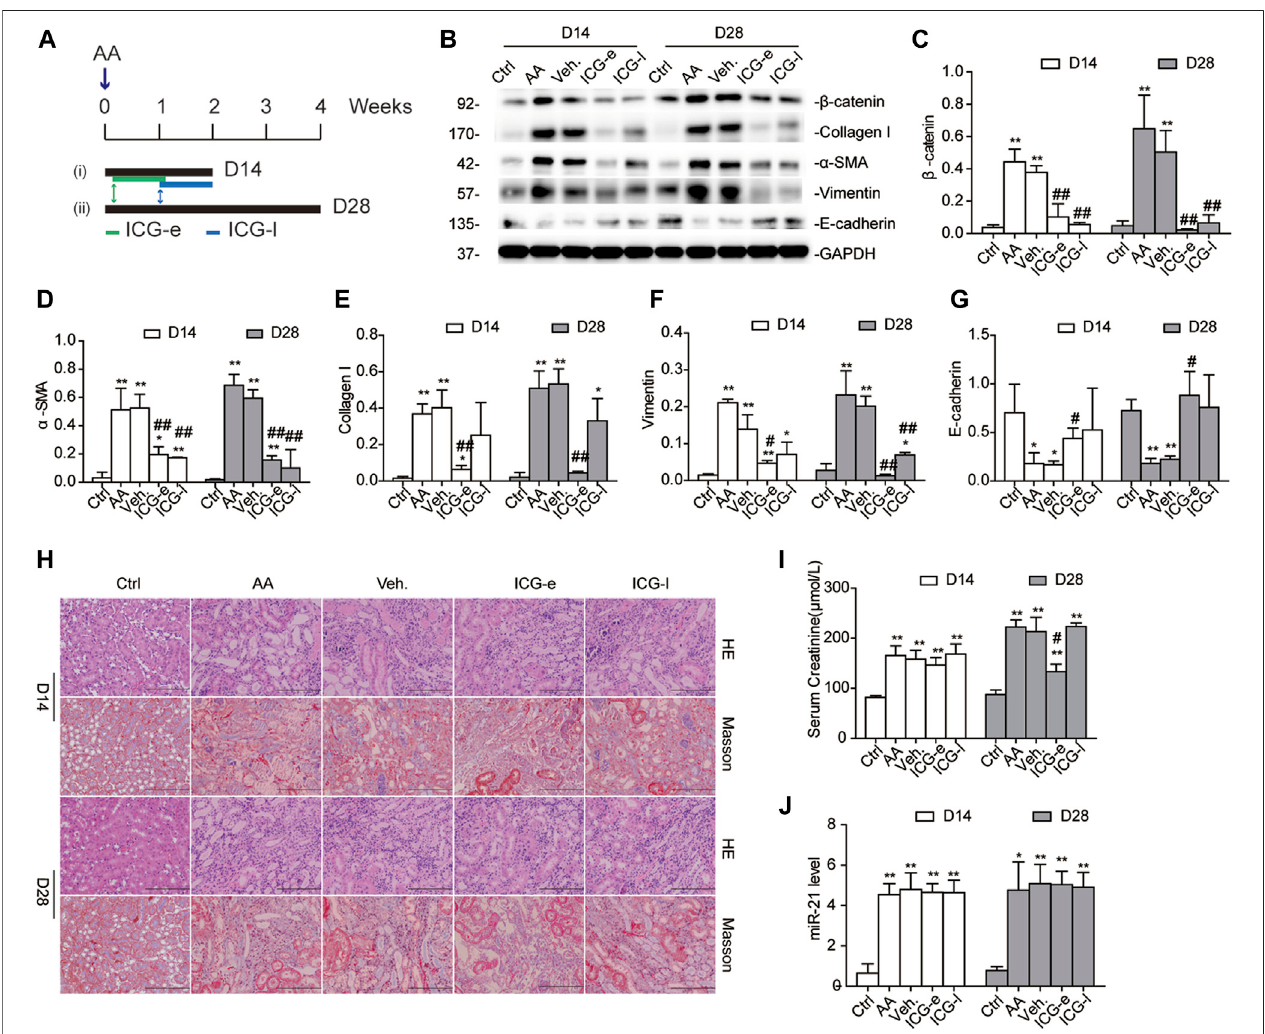
FIGURE 5| The timing of β -catenin inhibition determines thereversibility ofAKI-to-CKD transition in the mouse AAN model. (A) Diagram showing the experimental design. ICG-001 (5 mg/kg) was administrated daily for consecutive 7 days starting 24 h after AA delivery (ICG-e) or 7 d after AA delivery (ICG-l). Veh, ICG-e and ICG-l refer to vehicle controls, early and late ICG-001 treatment, respectively. Mice were sacri fi ced 14 days and 28 days post AA administration. (B – G) Western blots and quantitative data of β -catenin, α -SMA, collagen I, vimentin, and E-cadherin. (H) H&E and Masson ’ s trichrome staining of the corticomedullary junction (magni fi cation, 200 × , bar (cid:2) 200 μ m). Tissue damage and renal fi brosis scores were calculated as described in the Methods. (I) Serum levels of creatinine on days 14 and 28 days after AA delivery. (J) RT-qPCR results of miR-21 abundance in the kidneys. * p < 0.05, ** p < 0.01 vs. controls. # p < 0.05 and ## p < 0.01 vs. vehicle controls (Veh), n (cid:2)